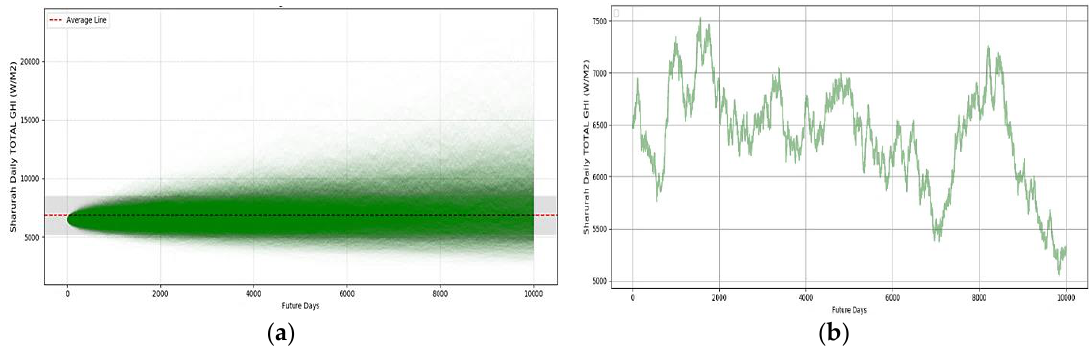
Figure 9. ( a ) Daily total solar GHI distributions for the southern region, as predicted by MCS and BM, and ( b ) a one-day scenario for the solar GHI distribution prediction performance.